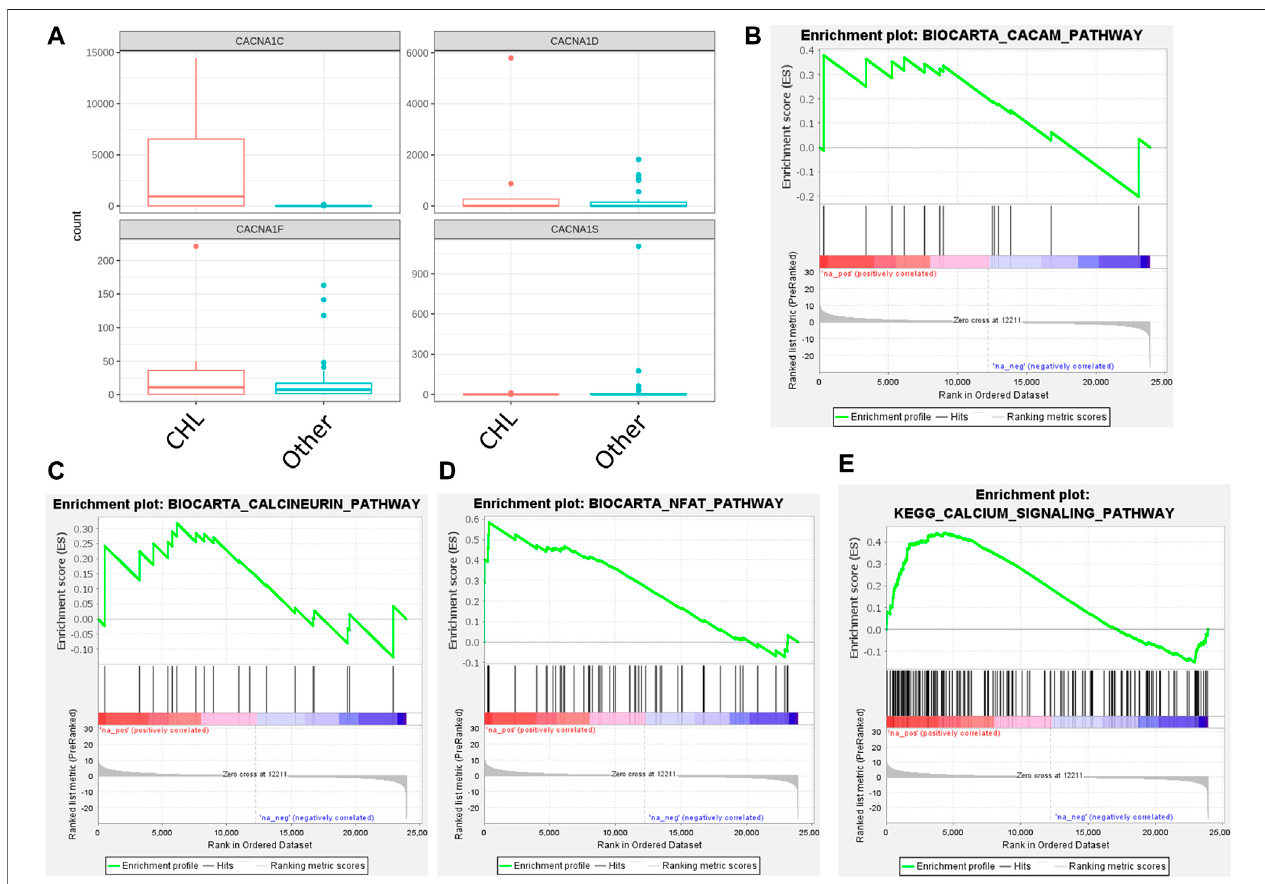
FIGURE 2 | Ca V 1 channel expression and BioCarta/KEGG pathways in CHL cell lines. (A) Ca V 1 channel expression (CACNA1S, Ca V 1.1; CACNA1C, Ca V 1.2; CACNA1D, Ca V 1.3; CACNA1F, Ca V 1.4) in CHL and other B cell lymphomas. (B – E) Pathways for (B) calmodulin (BioCarta), (C) calcineurin (BioCarta), (D) NFAT (BioCarta), and (E) Ca 2+ signaling (KEGG) were assessed for enrichment in the CHL cell lines relative to other varieties of B cell